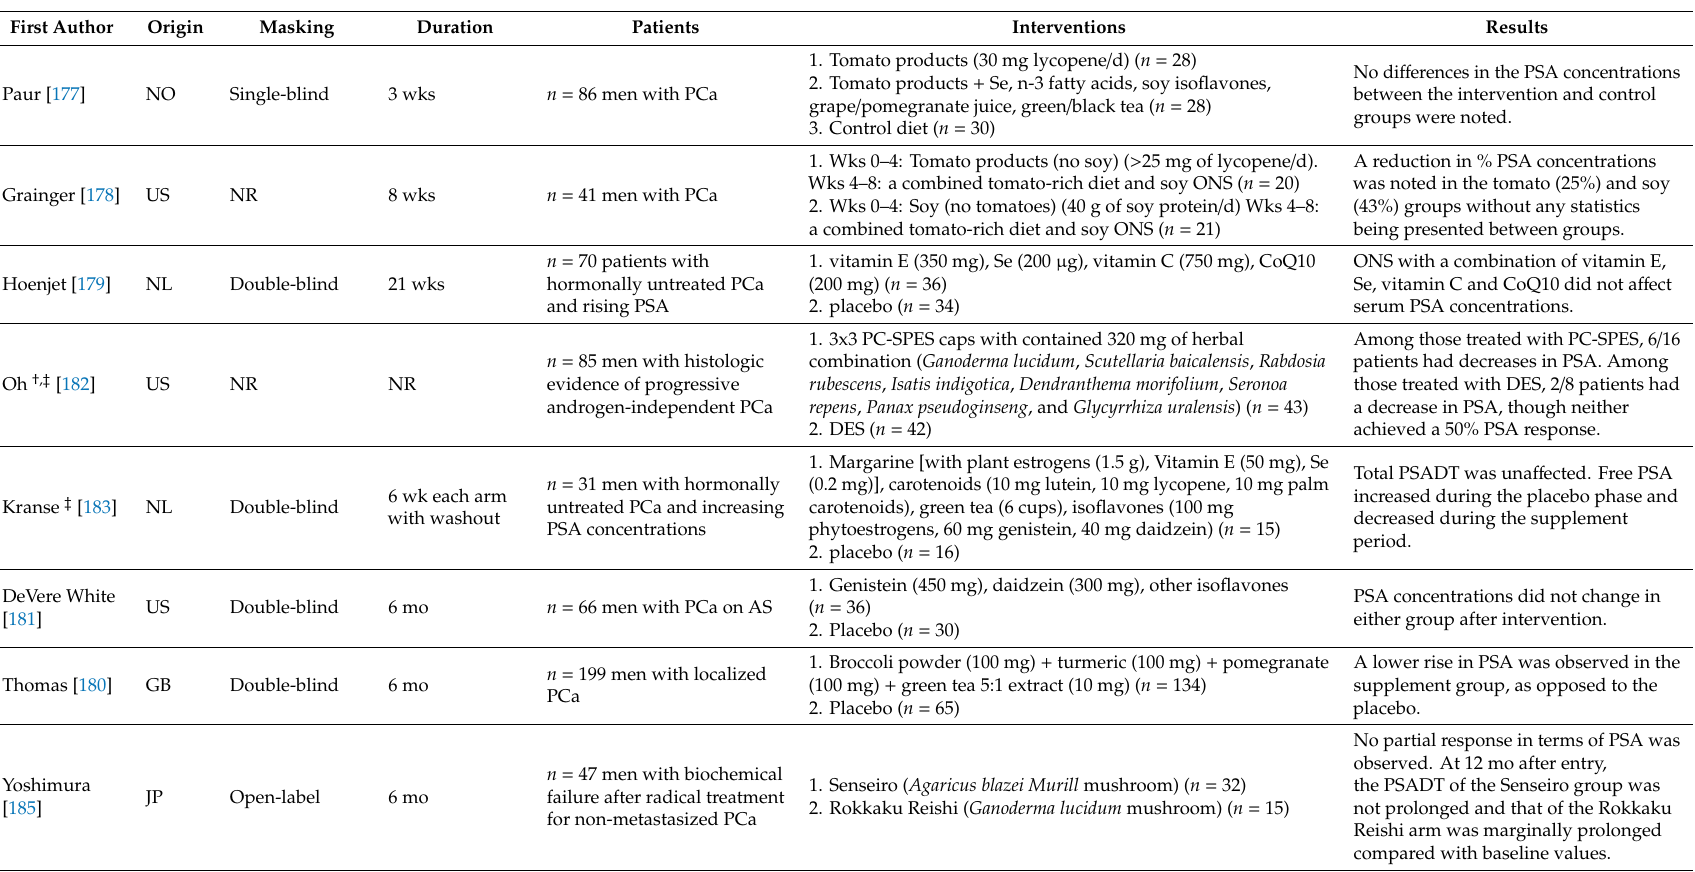
Table 9. RCTs examining the e ff ect of combined antioxidant supplementation on PSA concentrations among men with PCa or increased PCa